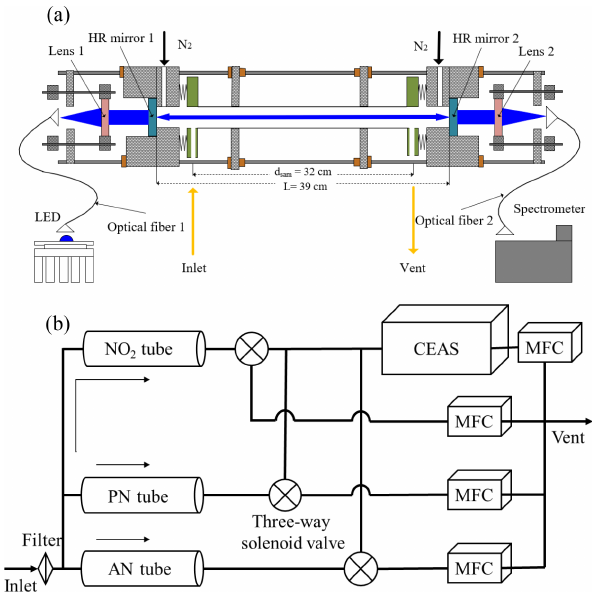
Figure 1. The overall schematic of the CEAS (a) and the instru- ment (b) . The CEAS is mainly composed of LEDs, collimating optics, a cage structure, a high-finesse cavity, and a spectrome- ter. After filtering the PM, the gas passes through three quartz tubes, and then the alternate measurements of NO 2 , NO 2 + PNs, and NO 2 + PNs + ANs are achieved by three-way solenoid